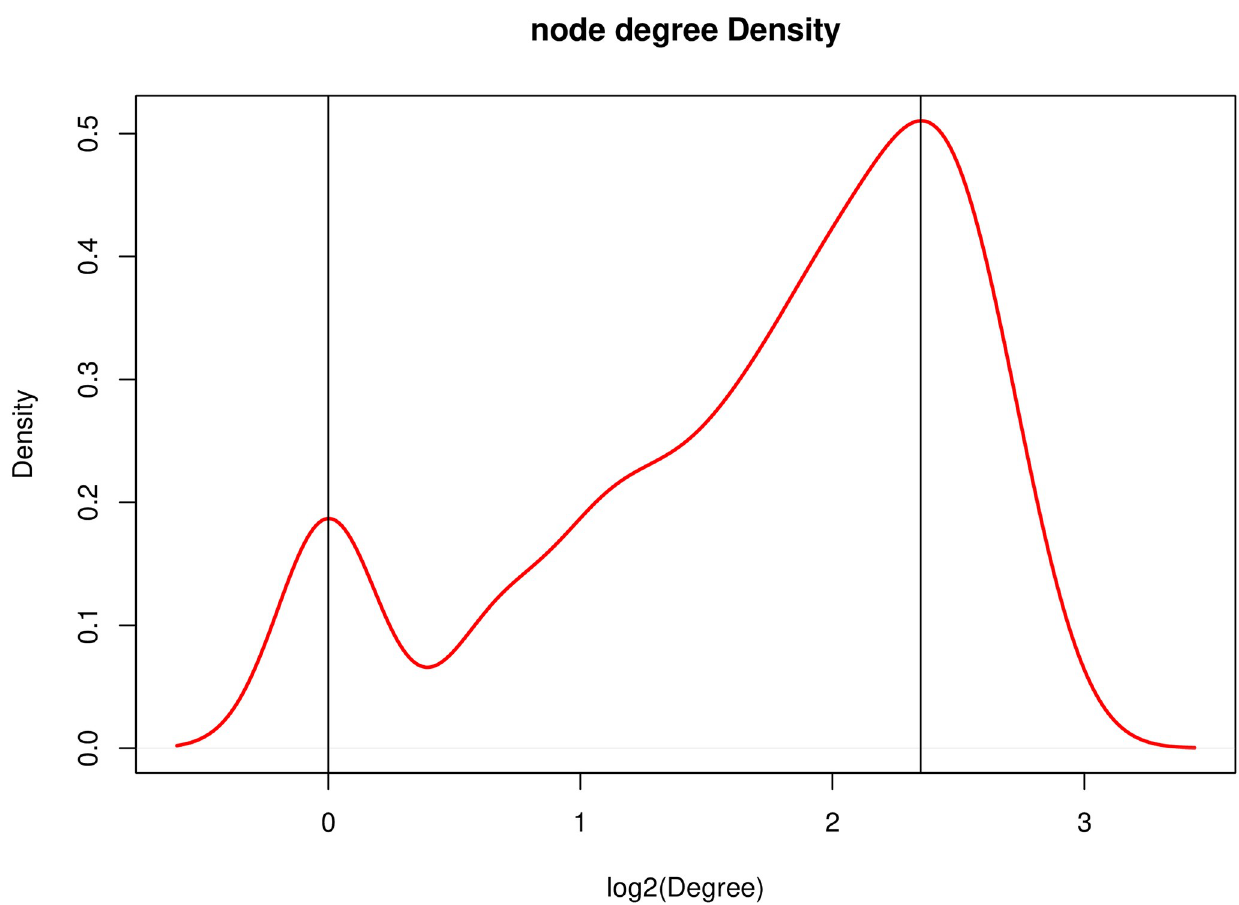
Fig 8. Degree distribution of nodes. The x-axis represents the log-transformed degree and the y-axis represents the